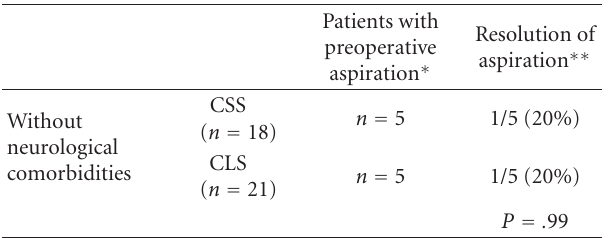
Table 2: Resolution of Aspiration.